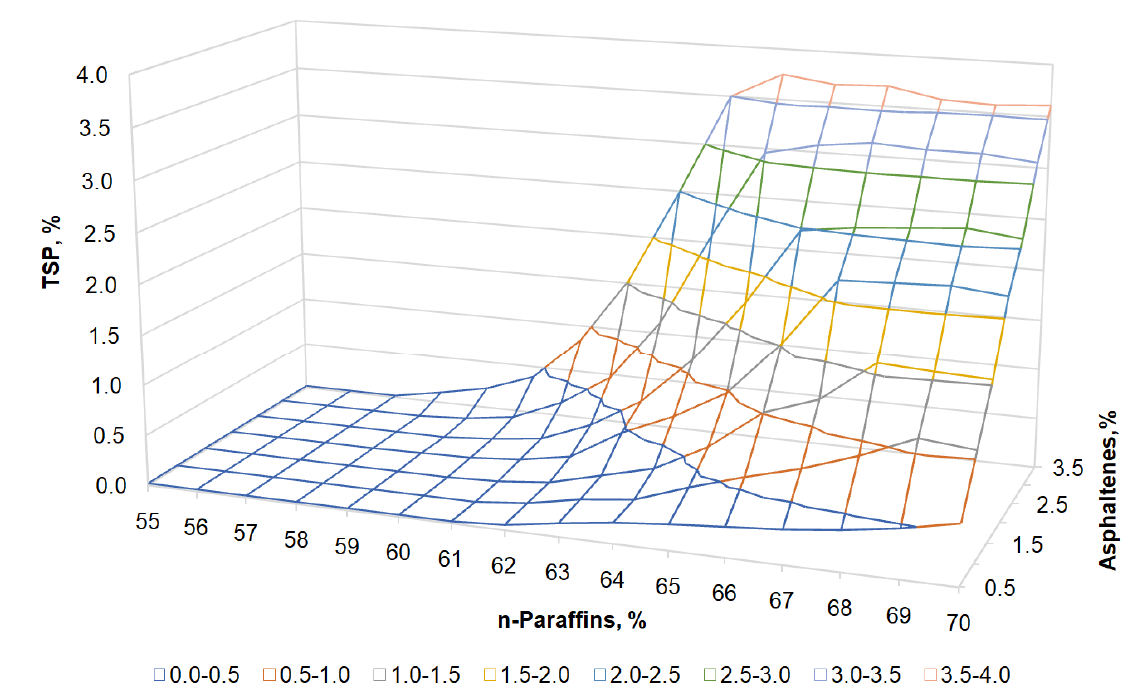
Figure 7. Three-dimensional visualization of the resulting experimental data on the influence of n-paraffins and asphaltenes on the manifestation of incompatibility.